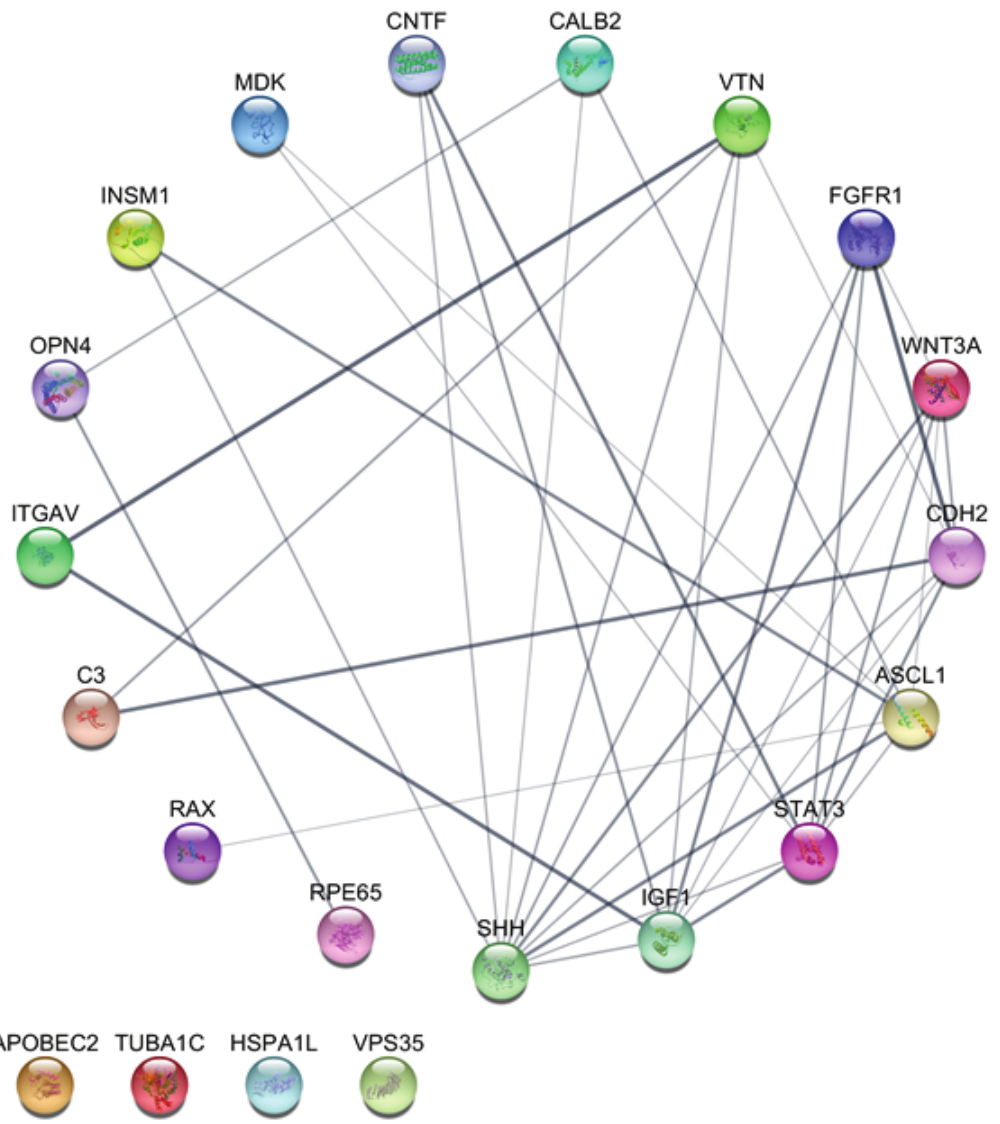
Figure 2. The degree-sorted circular layout of the PPI network performed by STRING App in Cytoscape 3.7.2. Each circle provides a schematic drawing of protein structure. The colors are set randomly, and the connection line’s thickness illustrates the relation of power. Also, a thicker line presents much more evidence and documents to approve the